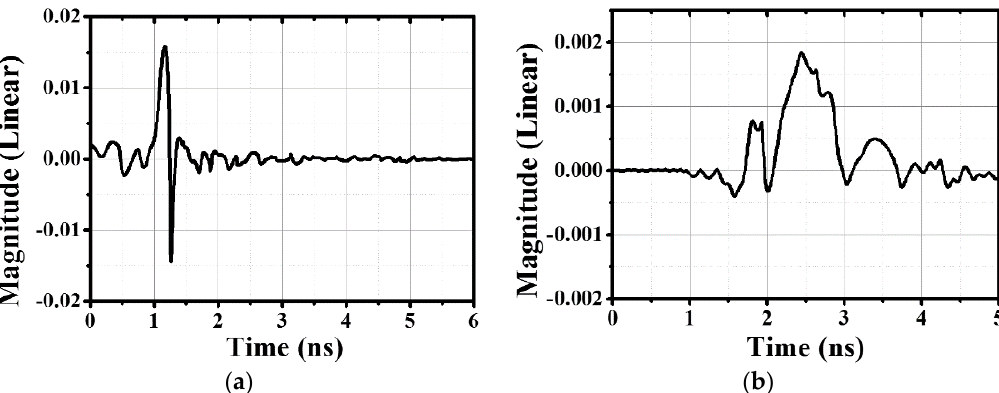
Figure 14. The difference of the backscattered time domain signal ( a ) reflected scattering signal, and ( b ) transmitted scattering signal.